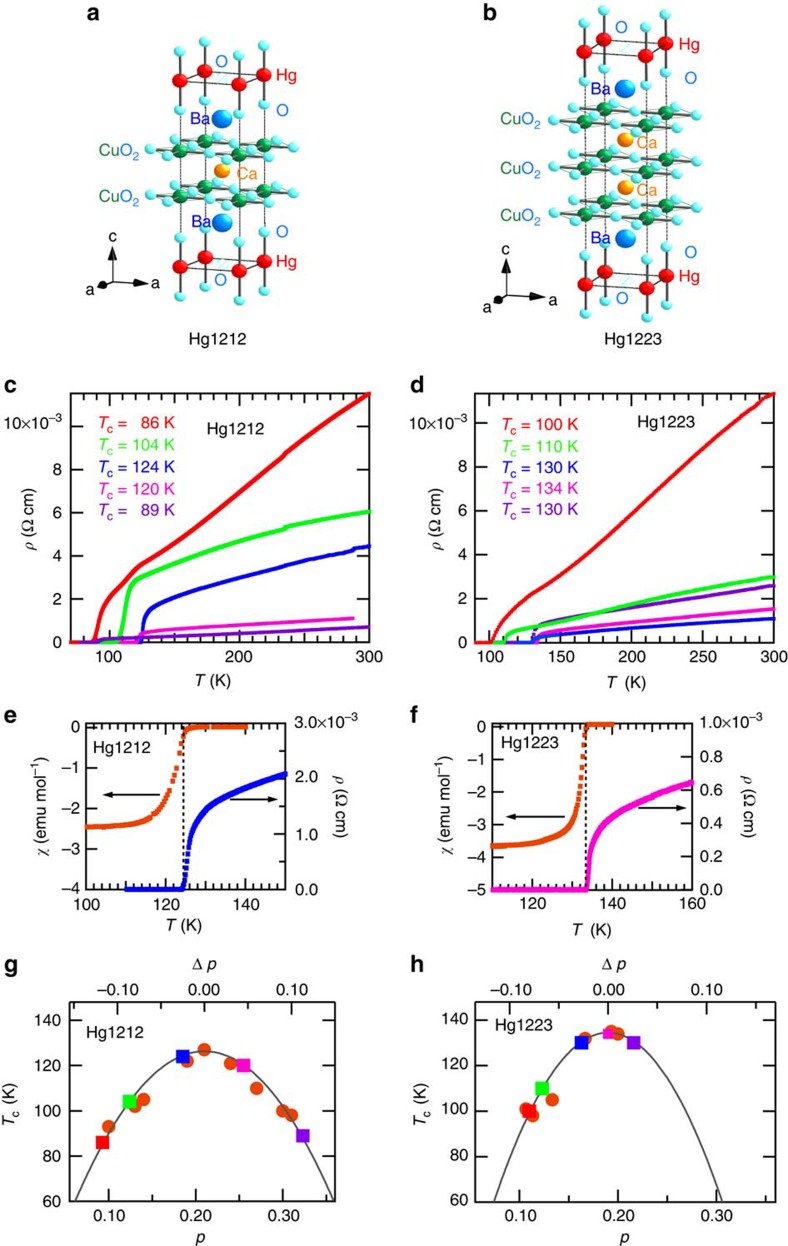
Characterization of Hg1212 and Hg1223.(a,b) Crystal structure models of Hg1212 (a) and Hg1223 (b). Red, blue, yellow, green and light blue spheres correspond to Hg, Ba, Ca, Cu and O, respectively. Hashed circle indicates partially occupied oxygen. (c,d) Temperature dependence of resistivity (ρ–T) of Hg1212 (c) and Hg1223 (d) with various Tc. Colour of the curve corresponds to the text colour of Tc. (e,f) Correlation between ρ–T and temperature dependence of dc-susceptibility (χ–T) curves exemplified for Hg1212 (Tc=124 K) and Hg1223 (Tc=134 K). (g,h) Estimation of hole concentration (p) for Hg1212 (g) and Hg1223 (h) from a fitting curve (line) using the data in ref. 13 (solid circle). Squared symbols are data of present study. Colour of the symbol corresponds to the colour of the resistivity in panels of (c,d). Δp stands for the value measured from the optimal doping value at ambient pressure; namely, Δp<0 for underdoped and Δp>0 for overdoped samples.